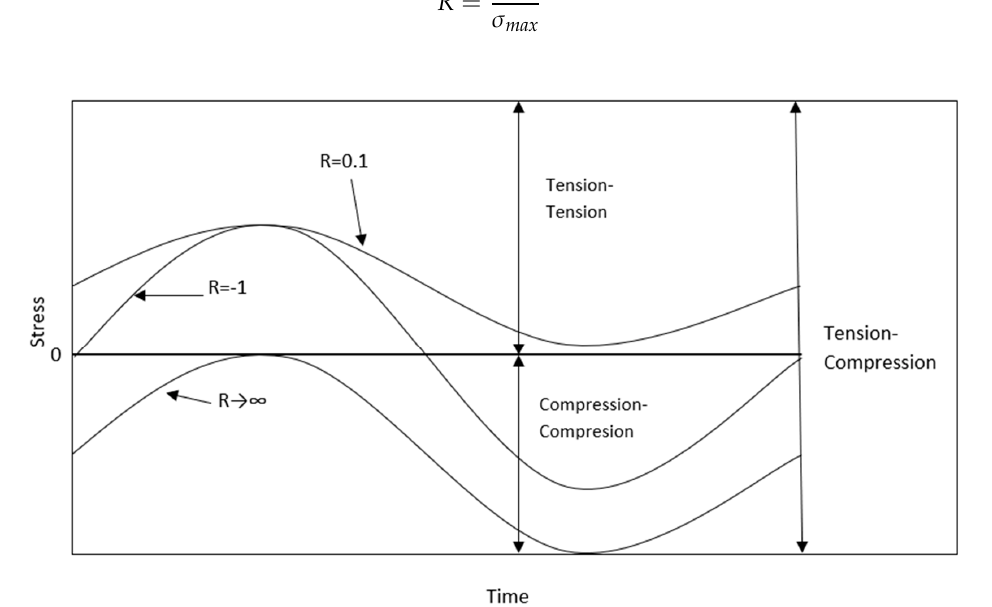
ff erent stress ratio Figure 1. Different stress ratio cases. Figure 1. Di